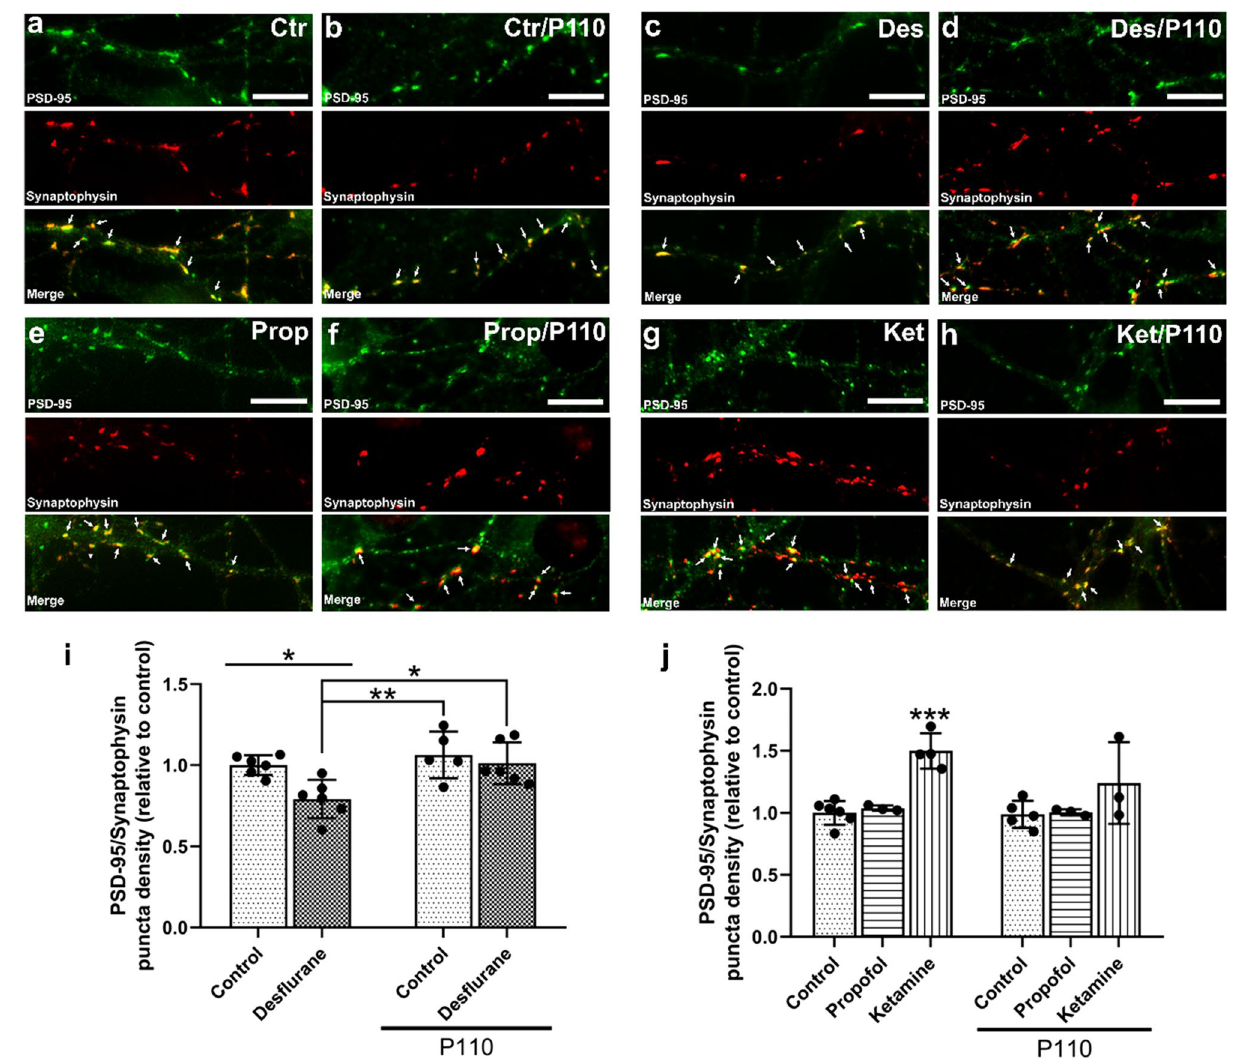
Figure 4. Desflurane but not propofol decreased synaptic protein expression whereas ketamine increased synaptic protein expression, P110 attenuated anesthetic-induced detrimental changes to synaptic assembly. Representative fluorescent images of cortical neurons stained for PSD-95 and synaptophysin at day in vitro 10 (a–h) . Each arrow on the merged images indicates examples of synaptic puncta along the neurite lengths as identified by the juxtaposed expression of pre-synaptic and post-synaptic labels that result in a distinctly yellow overlapping region. Quantification of average PSD-95/synaptophysin puncta per neurite length relative to control (i–j) . Exposure to 4.3 Vol% desflurane decreased average synaptic puncta density. Treatment with 10 µM propofol did not affect average synaptic puncta density. Treatment with 5 µM ketamine increased average puncta density. P110 alone did not affect synaptic network assembly, whereas its pre-treatment mitigated desflurane- induced pertubations and partially prevented ketamine-induced synaptogenesis. P110 followed by propofol treatment did not differ from control. Two-Way ANOVA. * p < 0.05, ** p < 0.01, *** p < 0.001, as determined by pairwise comparison of post-hoc tests. Bars indicate ± SD measured across biological replicates. Each data point indicates the mean synapse density per biological replicate. Scale bars indicate 5